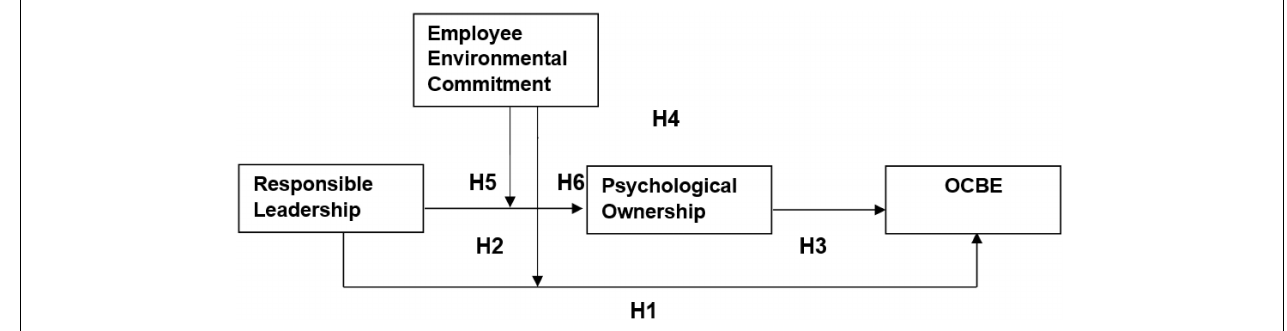
FIGURE 1 | Model of this